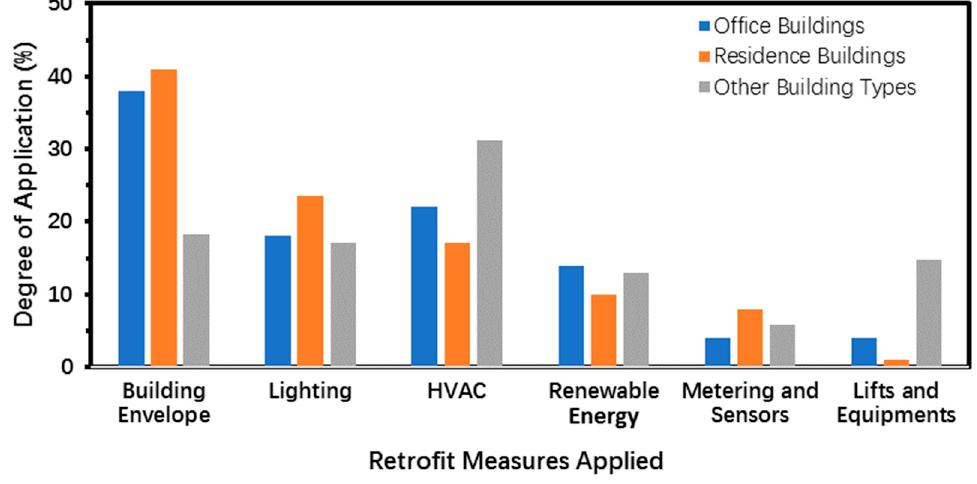
ff erent retrofit measures on di ff erent building types (n-size = Figure 8. Degree of application of different retrofit measures on different building types (n-size = 19). Figure 8. Degree of application of di